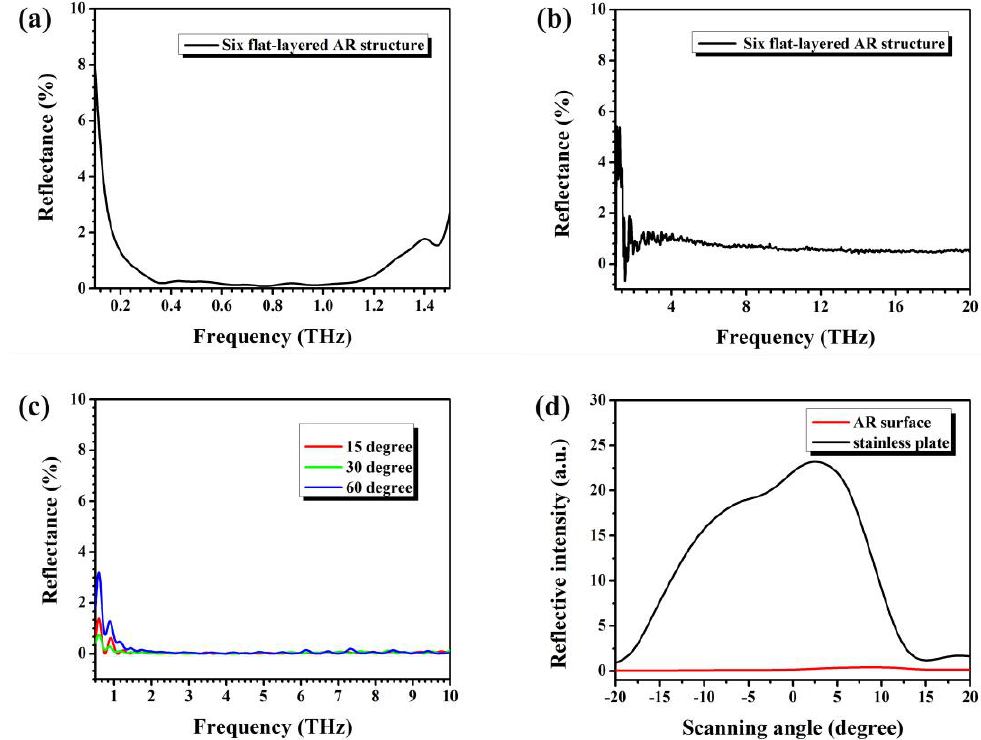
Figure 7. AR effects of a flat six-layer structure. ( a ) Reflection spectrum from 0.1 to 1.5 THz measured by using THz–TDS. ( b ) Reflection spectrum from 1.5 to 20 THz measured by using FT-IR. ( c ) Reflection spectra from 0.5 to 10 THz with different incident angles simulated by CST Microwave Studio. ( d ) Surface scattering intensities as a function of detection angle.